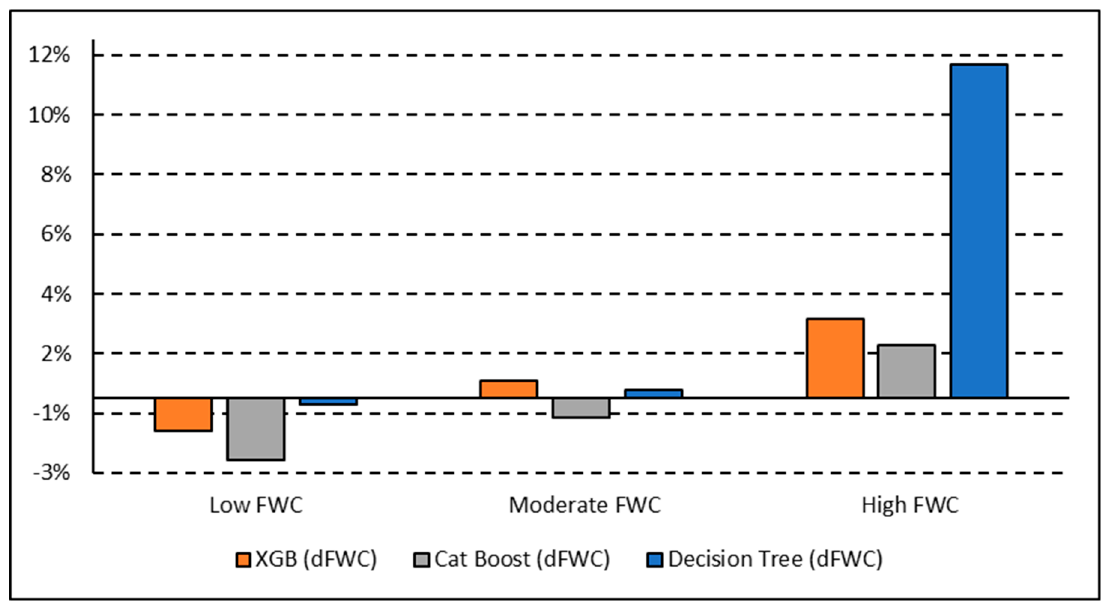
Figure 11. dFWC for the binary XGB, Cat Boost, and Decision Tree models. dFWC is highest for plots with high FWC with Decision Tree having the highest dFWC (11.17%). This pattern of declined model prediction accuracy occurring with increased site complexity is in agreement with suggestions made by [23].